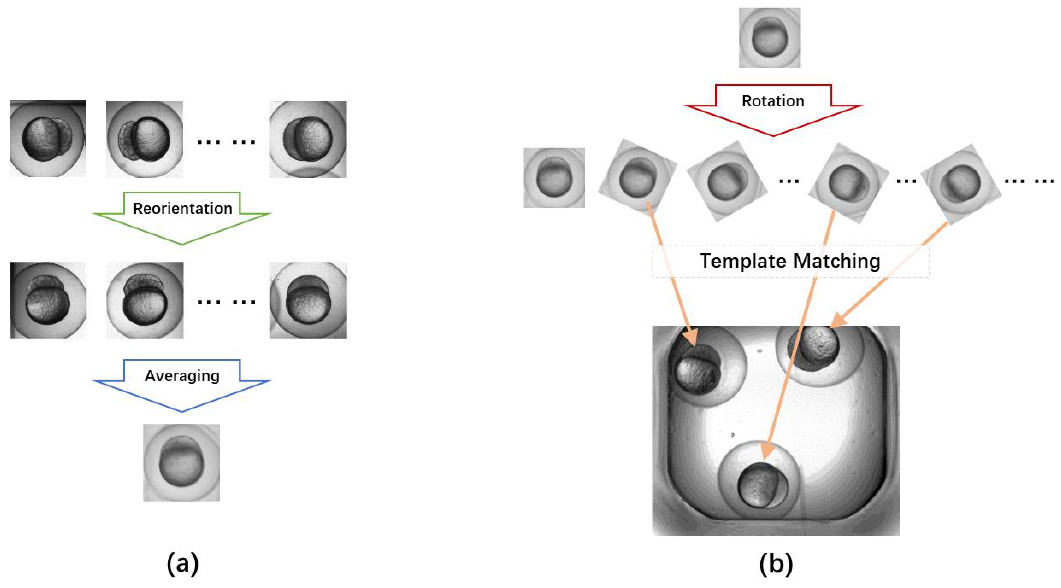
Figure 3. The workflow of egg detection. ( a ) The egg template is created by averaging K patches of egg samples; ( b ) The egg template is rotated into different directions, and each rotated patch is moved through the target image to find its matched egg.